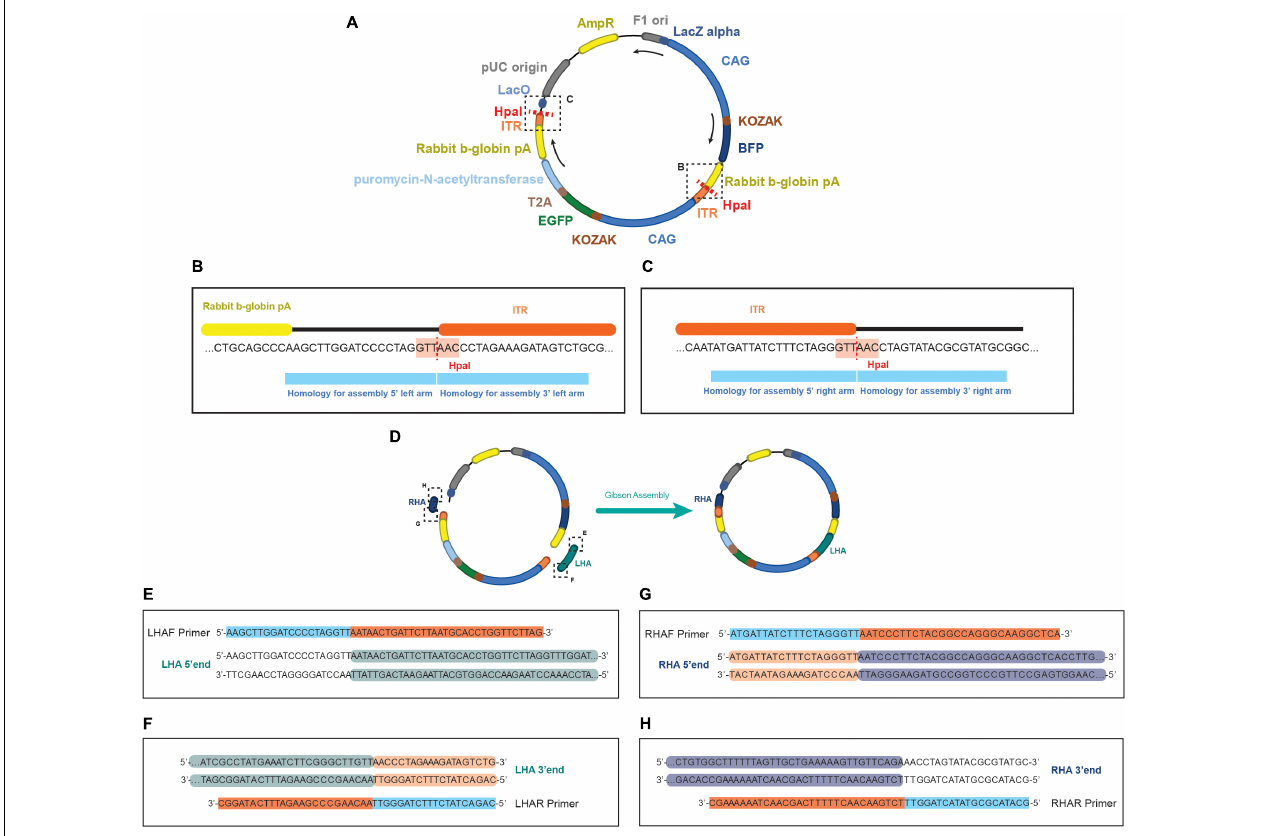
FIGURE 3 | Schematics of the EGFP donor plasmid and the homology in the primers for performing the assembly. (A) Representation of the pDONOR-tagBFP-PSM-EGFP with the restriction sites of HpaI. (B) Close up of the HpaI region where the left homology arm will be assembled. (C) Close up of the HpaI region where the right homology arm will be assembled. (D) Representation of the donor after assembly. On each primer from ( E – H ) it is represented in light blue the homology to the donor and in orange the homology to the genomic region of the example. Every double stranded DNA section in E – H represents the sequence of the homology arms to be assembled, showing in green (E,F) the genomic sequence incorporated in the left arm, and in dark blue (G,H) the genomic sequence incorporated in the right arm. In light orange (F,G) the homology in the arms to the ITR sequence of the donor, and unlabeled (E,H) the backbone of the donor